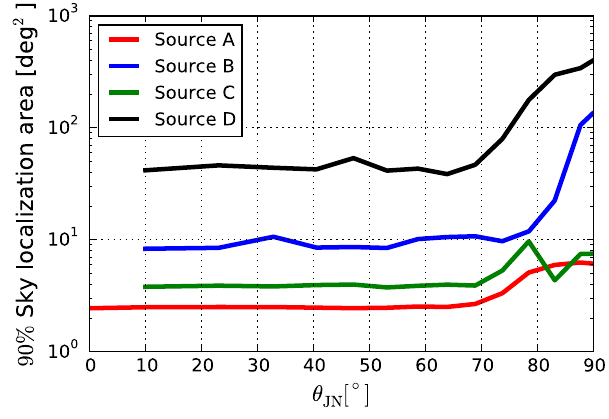
FIG. 3. Sky localization area (in deg 2 ) as measured by LALI NFERENCE , as a function of the binary inclination angle.